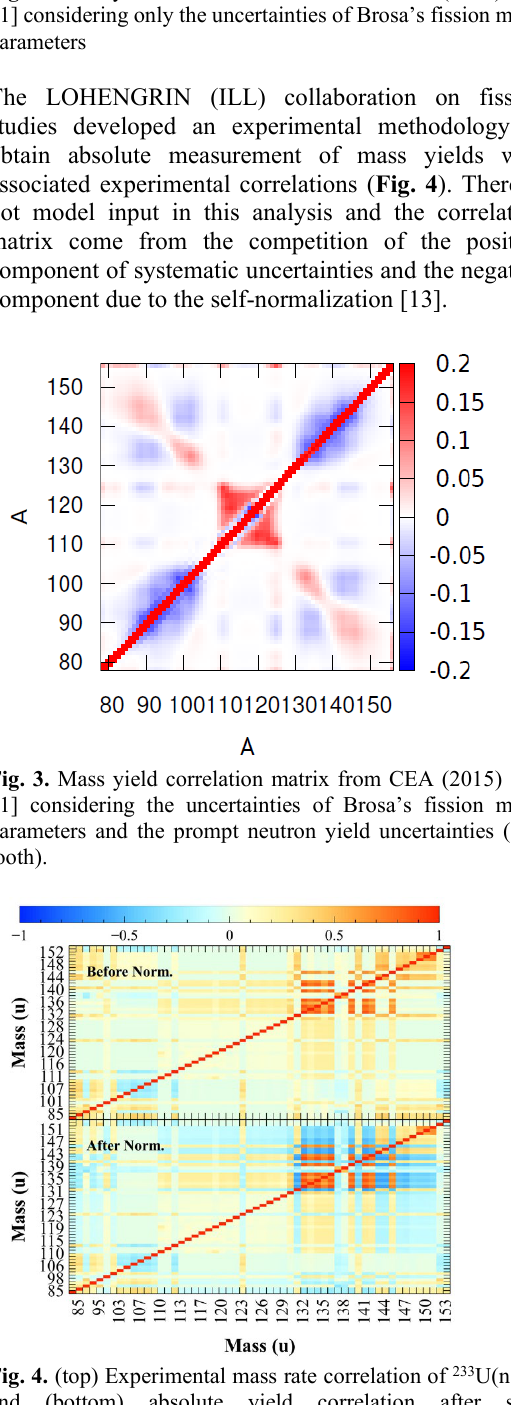
Fig. 4. (top) Experimental mass rate correlation of 233 U(n th ,f) and (bottom) absolute yield correlation after self- normalization